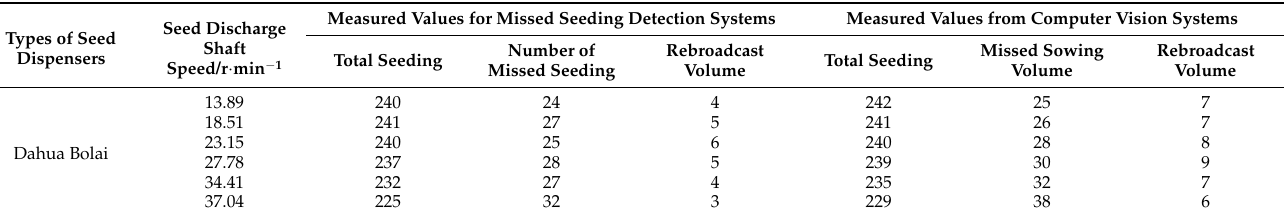
Table 4. The test results of loss sowing detection of precision sowing for